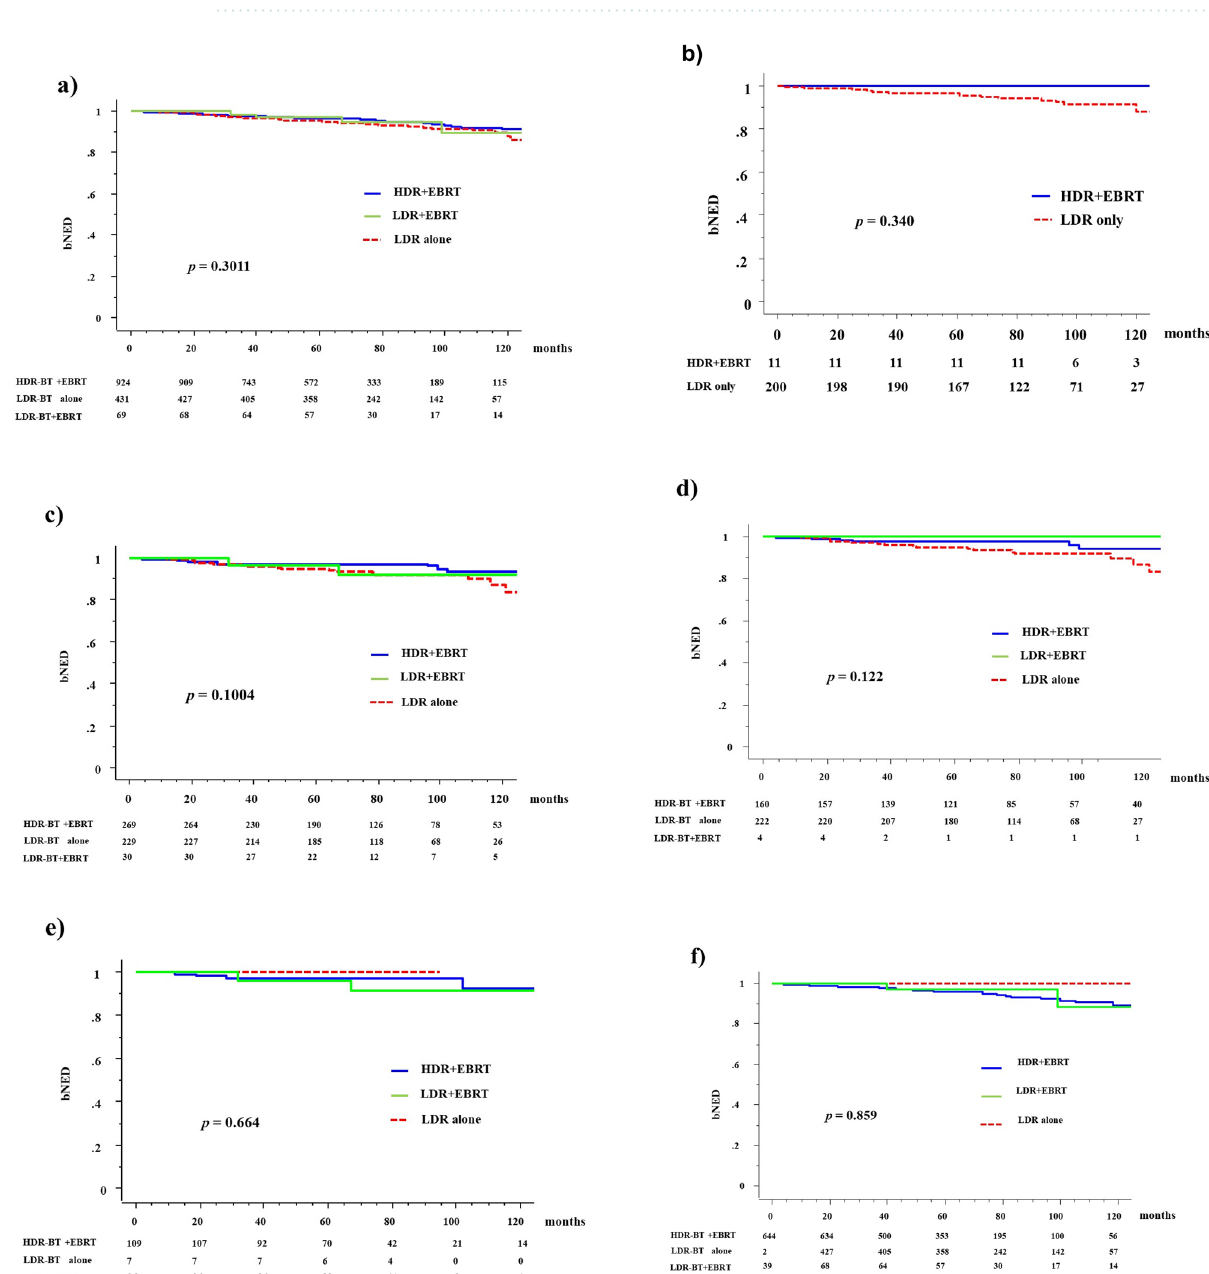
Figure 3. Biochemical control rates among three groups (HDR + EBRT vs. LDR + EBRT vs. LDR alone). ( a ) Biochemical control rates between HDR-BT with EBRT and LDR-BT with or without EBRT in the total population. ( b ) Low risk group. ( c ) Intermediate group. ( d ) Lower titer of intermediate group. ( e ) Higher titer of intermediate group. ( f ) High risk group. bNED = no biochemical evidence of